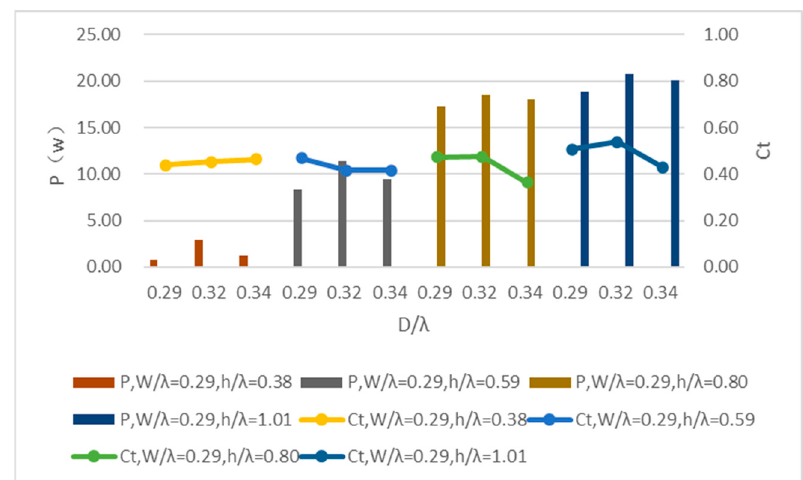
Figure 13. Numerical simulation data plot. Figure 13. Experimental data